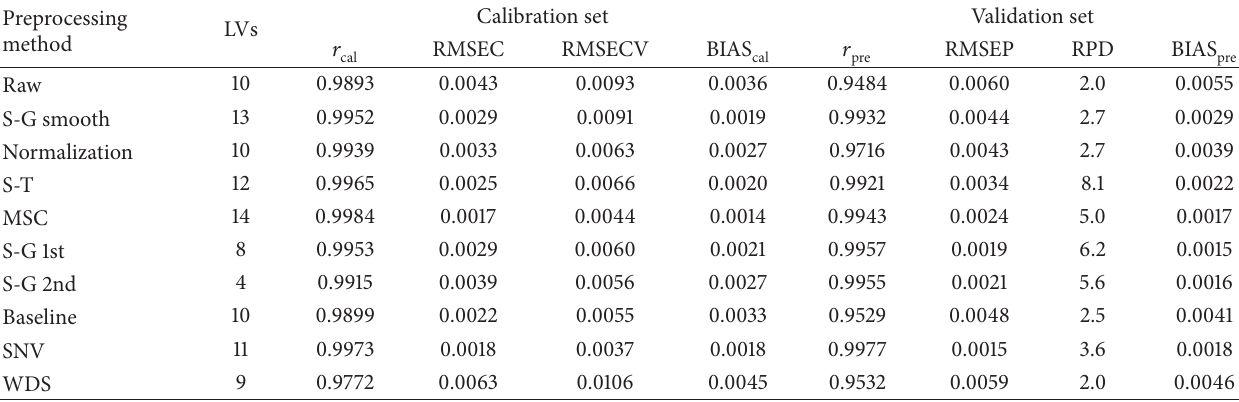
Table 7: Comparison of different preprocessing methods of the partial least squares model for the content of tanshinone IIA/mg ⋅ g −1 .